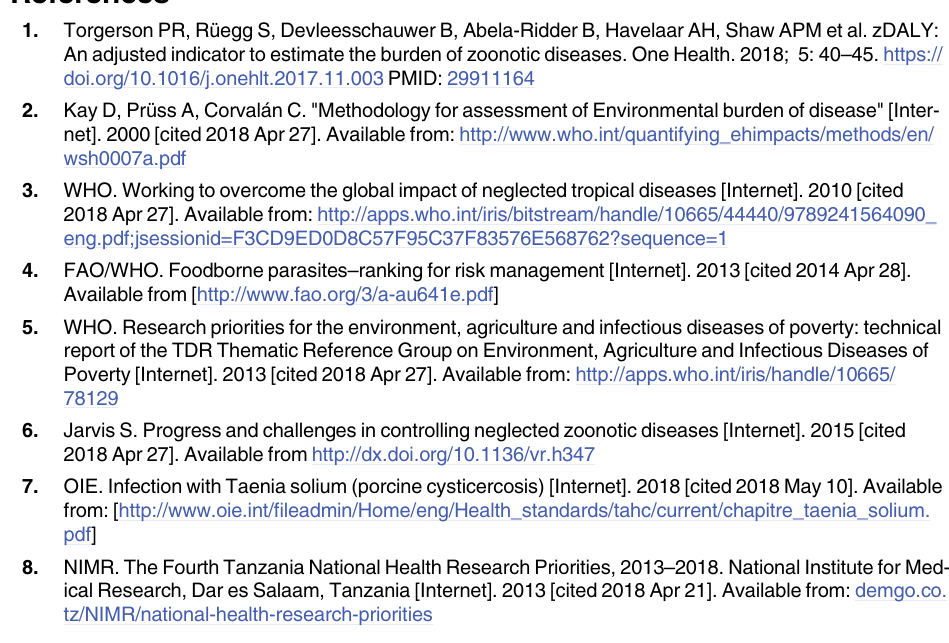
S2 Table. Fill list of terms searched for Taenia solium evidence in